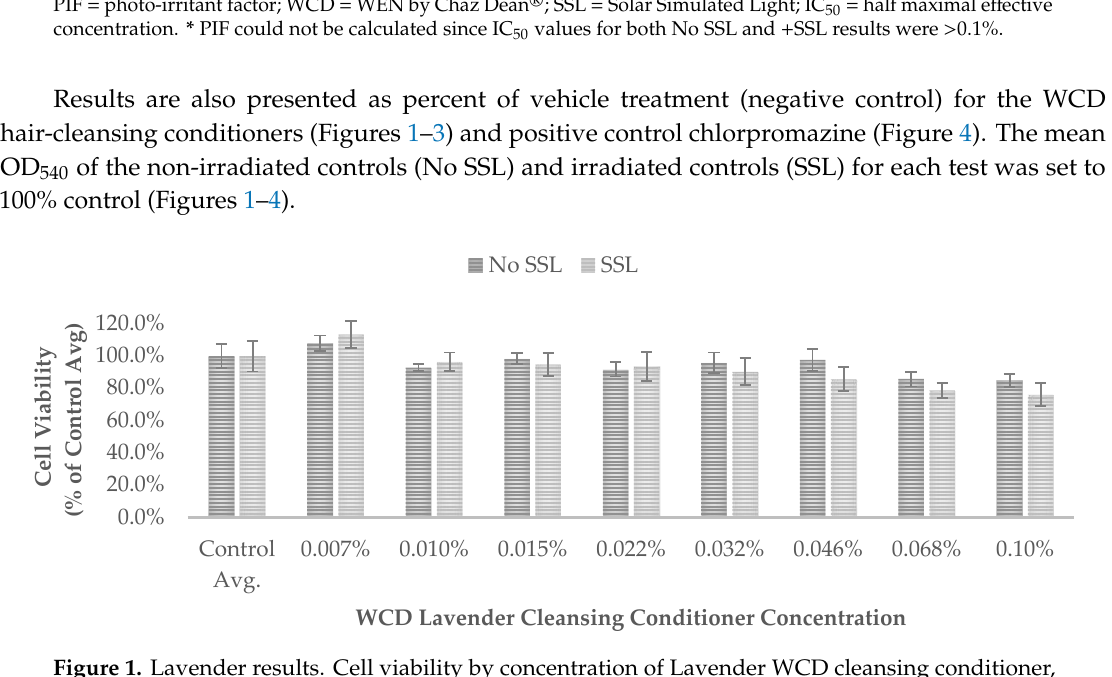
Figure 2. Pomegranate results. Cell viability by concentration of Pomegranate WCD cleansing conditioner, stratified by with and without solar simulated light (SSL). Figure 3. Sweet Almond Mint results. Cell viability by concentration of Sweet Almond Mint WCD cleansing conditioner, stratified by with and without solar simulated light (SSL).